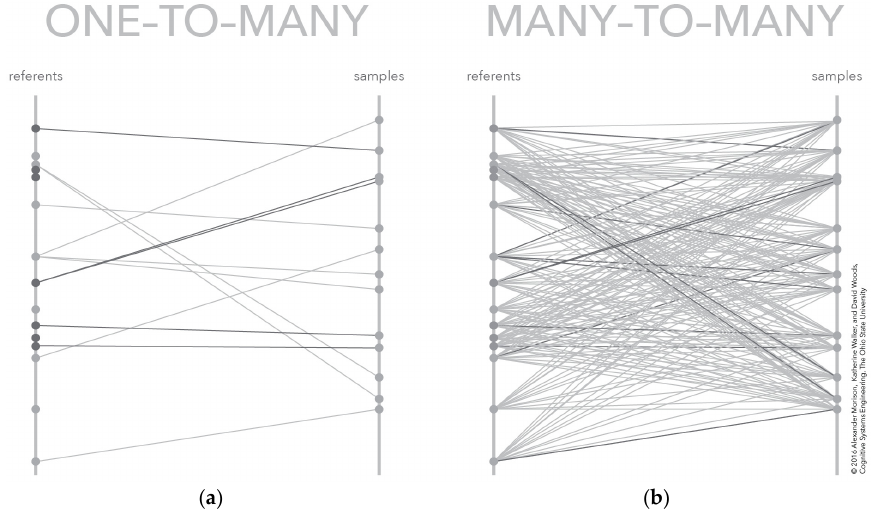
Figure 3. Two depictions of the conceptual model for similarity matching: ( a ) the typical algorithm results presented to an analyst, which include only the best referent-sample similarity scores; and ( b ) the similarity scores for all referent sample pairs, which are typically not provided because of the number of data values.